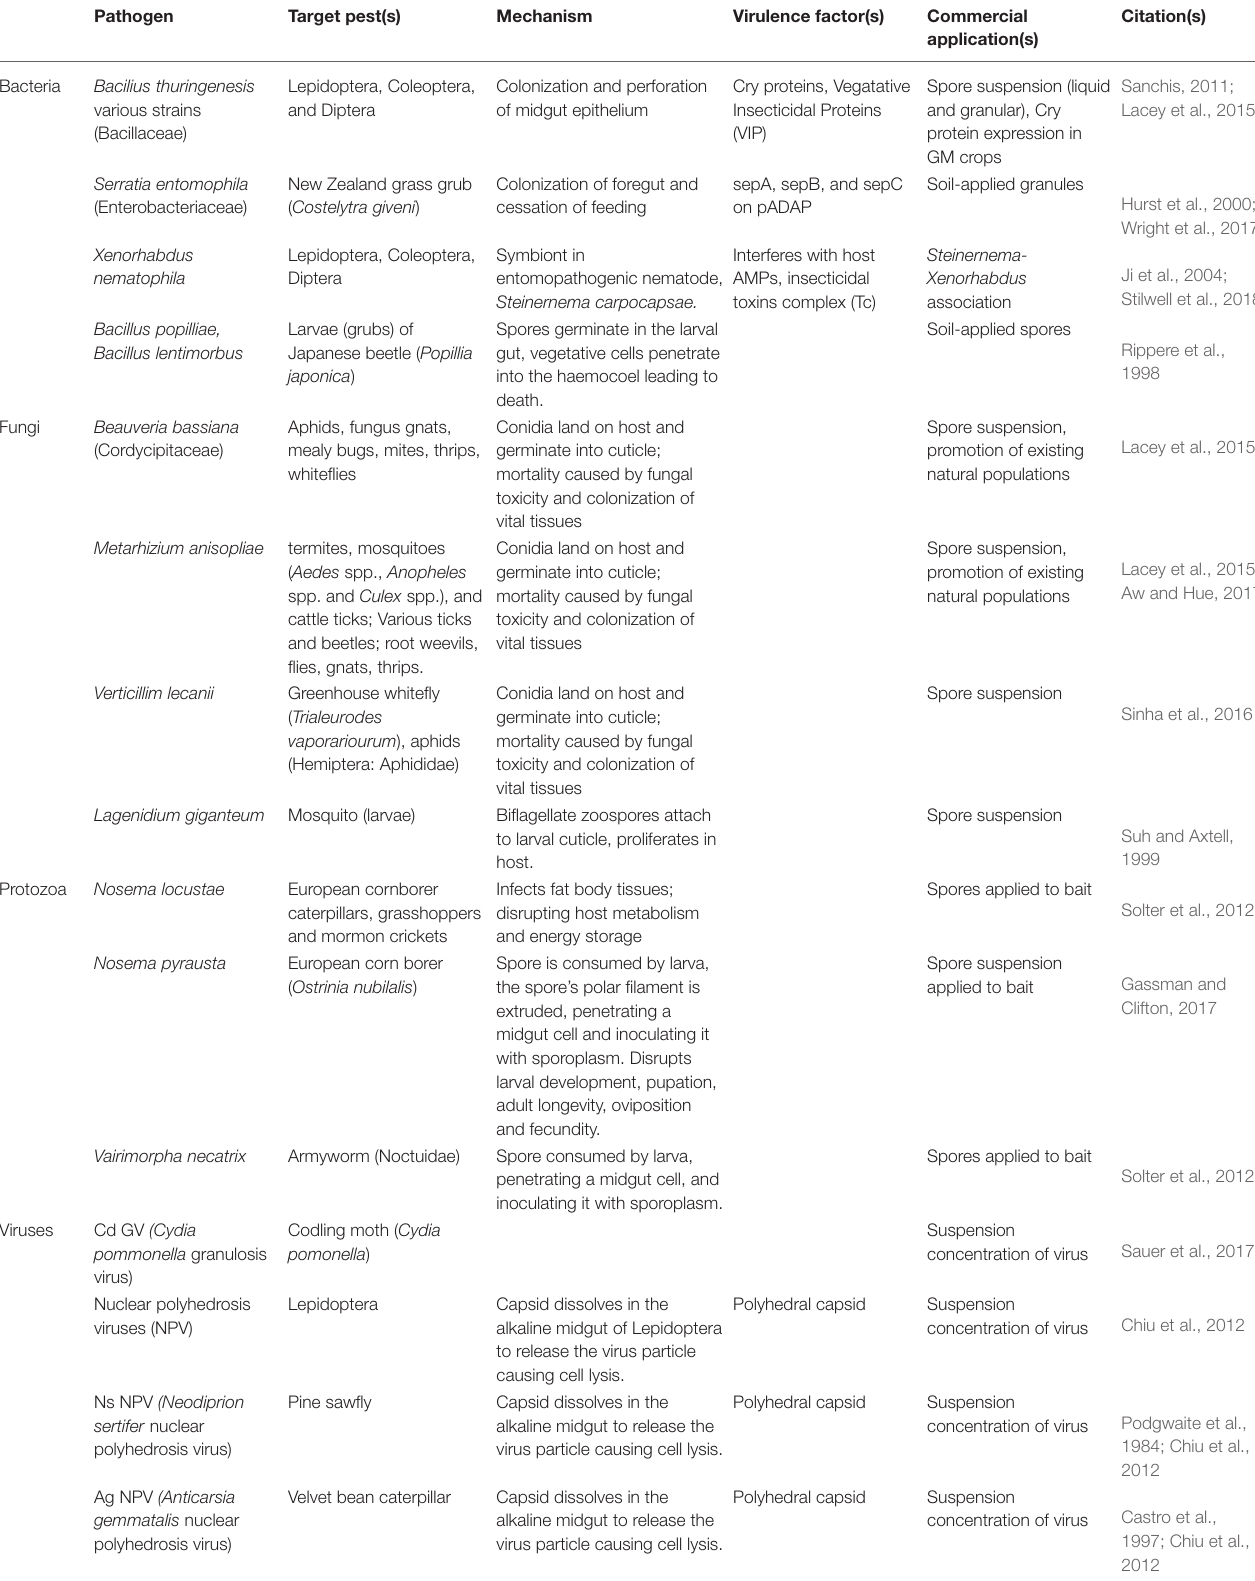
TABLE 1 | List of known bacterial, fungal, protozoa, and viral